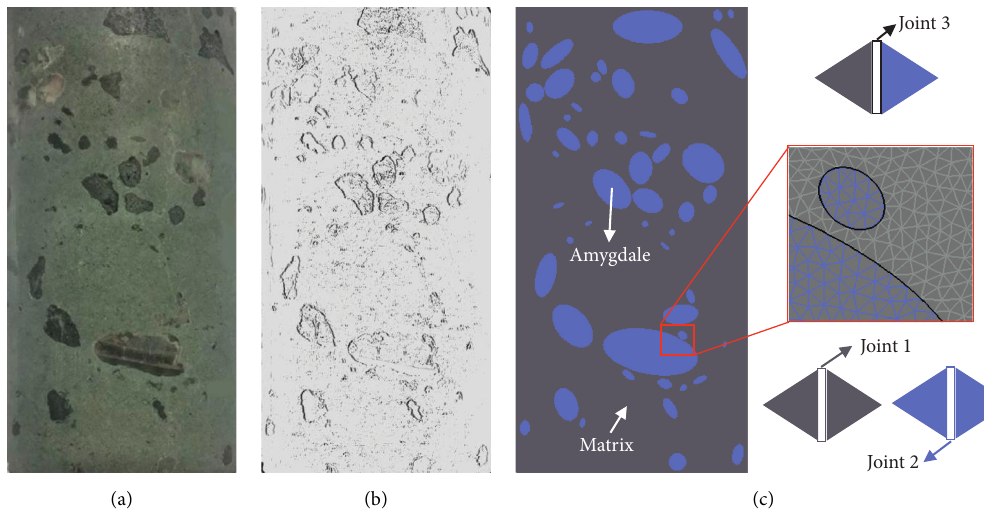
Figure 5: Modeling process of basalt microstructures. (a) Actual image of amygdaloidal basalt, and image size is 50mm × 100mm; (b) digital image of (a) processed by python; (c) amygdale boundary lines drawn using arcs.